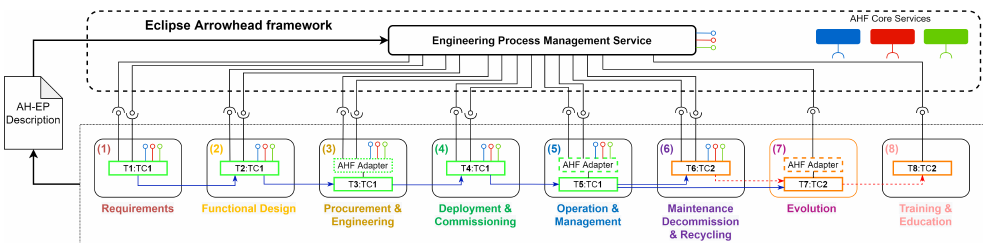
Figure 7. Example of the single-stakeholder Arrowhead-EP architecture based on the Eclipse Arrow- head framework (blue and red arrows represent the information